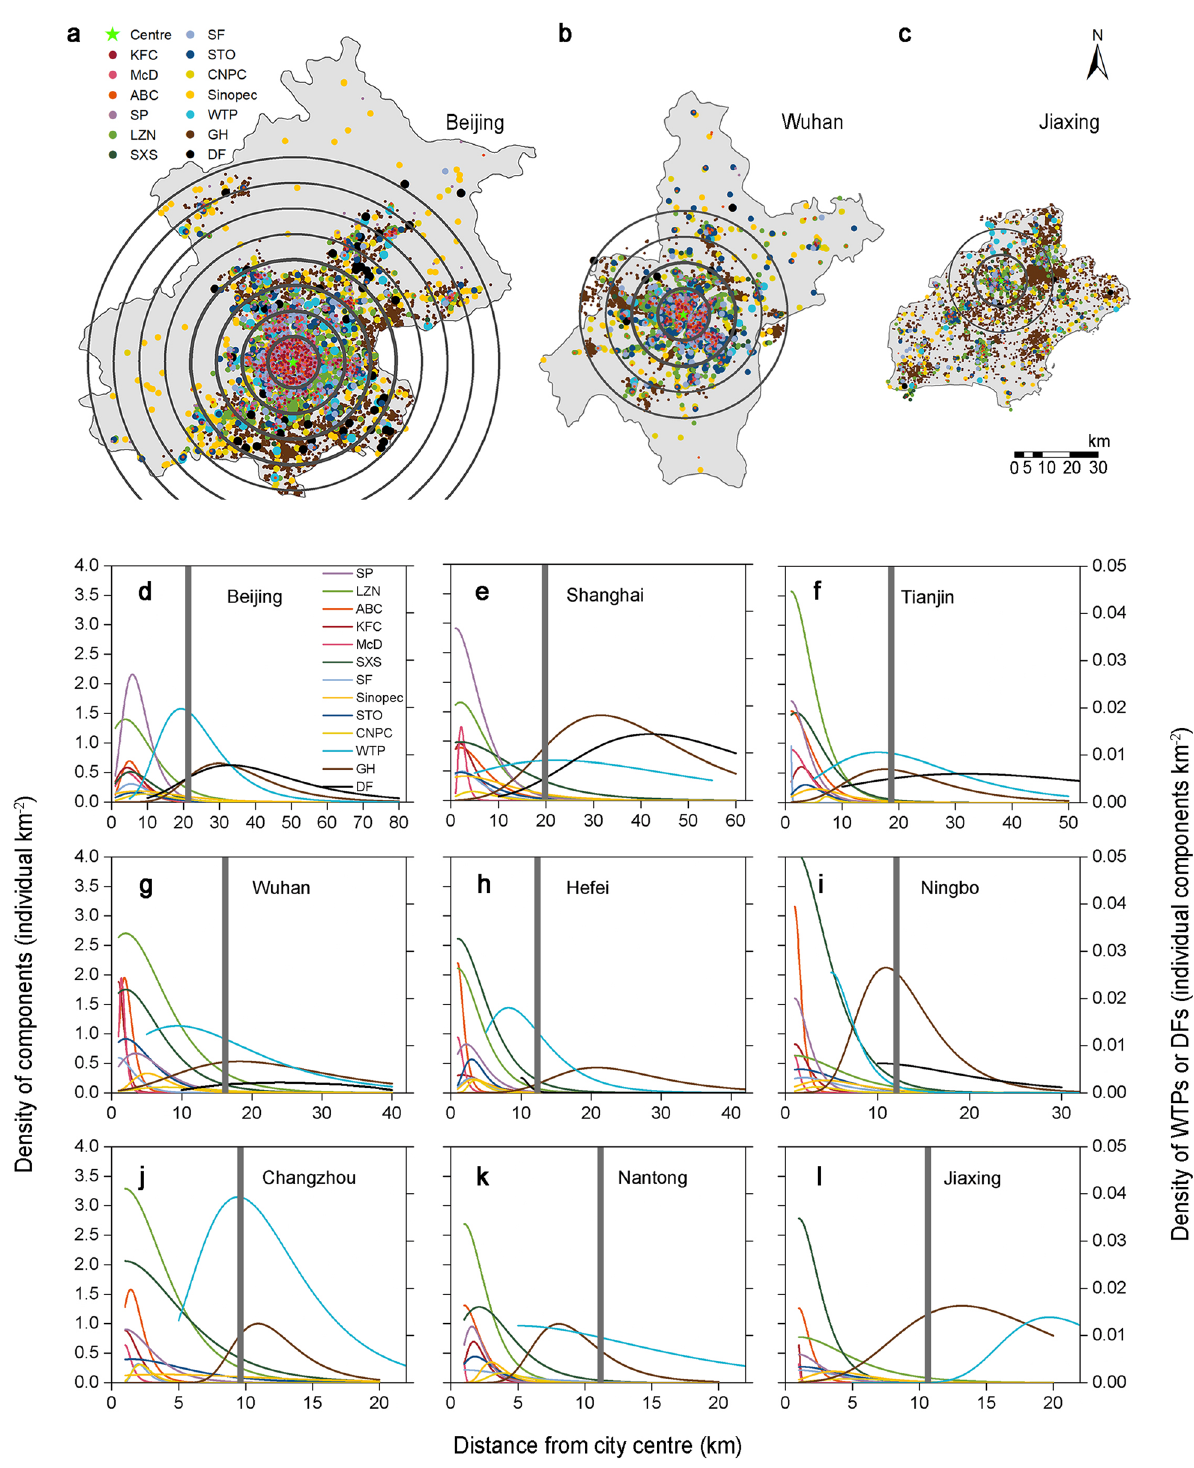
Figure 1. Spatial distribution of the various city functional components along urban–rural gradients. ( a–c ) Spatial point distribution of the various city functional components. The concentric rings are drawn from the city centre to the city edge, which are centred on the city centre, and the radius of the concentric rings is increased at 10-km intervals. The maps were created using ArcGIS 10.3 software (http:// www. esri. com/ arcgis/). ( a ) Beijing; ( b ) Wuhan; ( c ) Jiaxing. ( d–l ) Density distribution curves of the various city functional components along the urban–rural gradient. The boundary of the urban built-up area is marked with a grey band. The